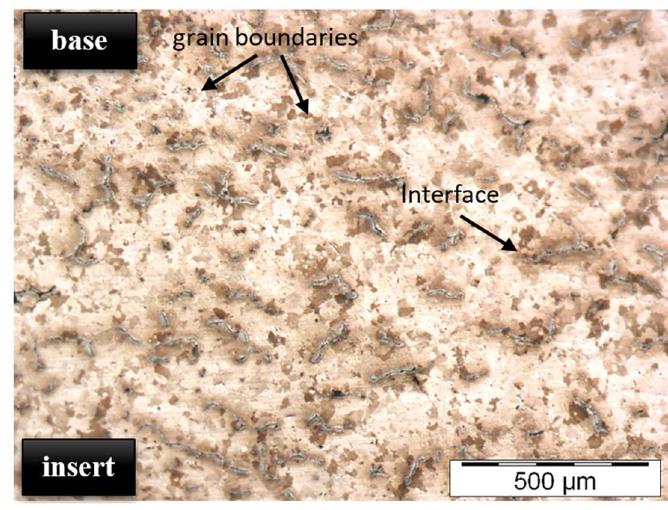
Figure 8. Microstructure of thixojoint parts after application of 1300 °C for 10 min and subjected to heat treatment.